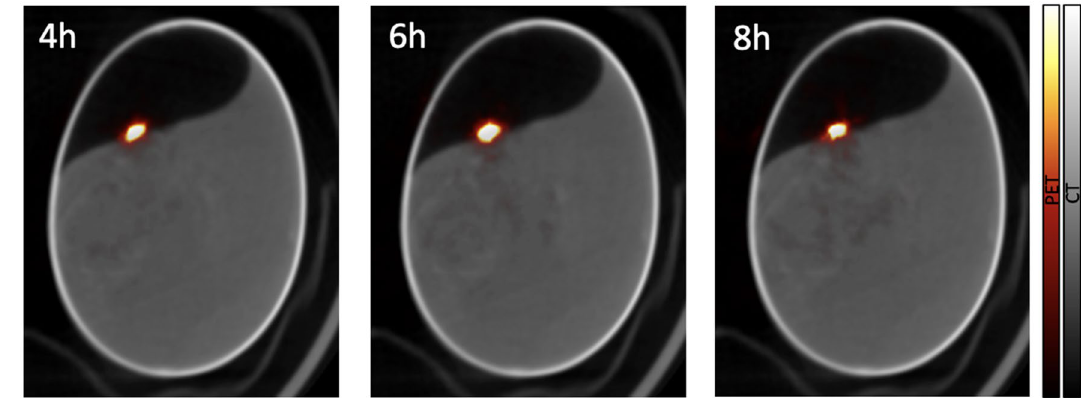
Figure 7. Fused PET and CT images obtained for E1 acquired 4 (left), 6 (middle), and 8 (right) hours after irradiation. The color scale of the PET images was adjusted for each particular